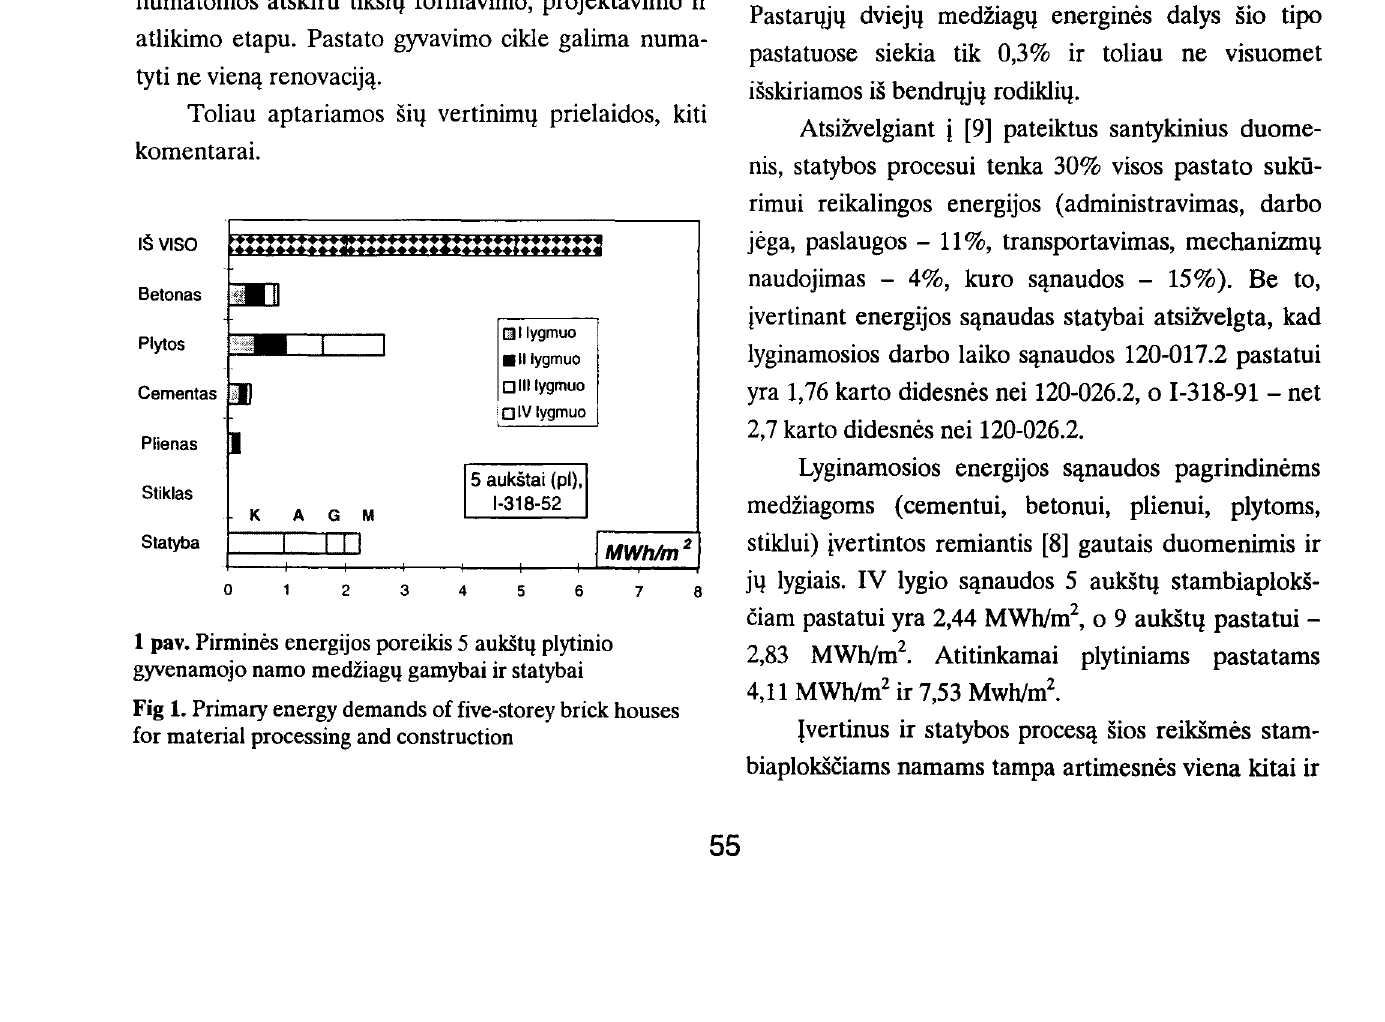
Fig 2. Primary energy demands for material processing and construction of dwelling